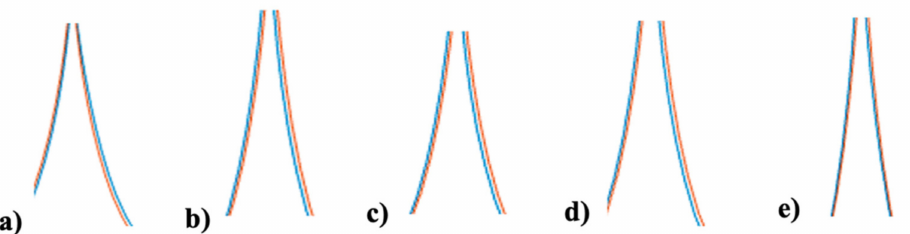
Figure 28. Extraction of the best trajectory for each method with perturbation. ( a ) Original BCO, ( b ) FBCO-T1FLS, ( c ) FBCO-IT2FLS, ( d ) FBCO-GT2FLS and ( e )